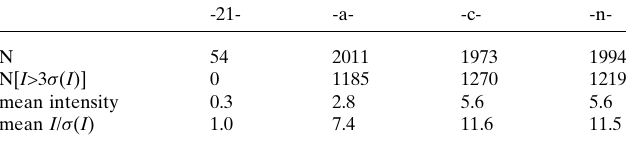
Table 3 Systematic absence exceptions for (I) (space group P 2 1 ).